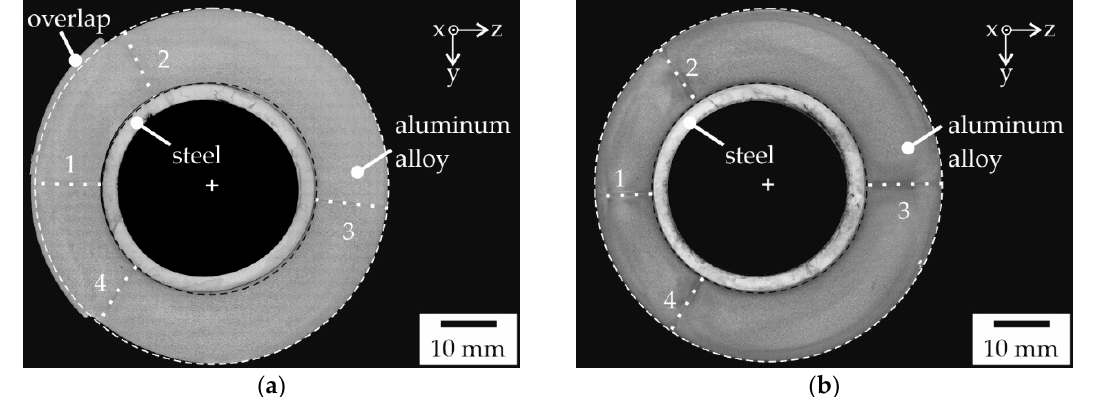
Figure 7. Cross-section of a sample taken from ( a ) the start of the compound profile, i.e., after a macroscopically closed longitudinal weld seam had formed and ( b ) the end of the compound profile, which was produced with an extrusion ratio of 9:1; etching: HF / H 2 SO 4 mixture; the position of the longitudinal weld seams is highlighted by dotted lines; the interpolated outer contour of the steel tube is highlighted with black dashed lines; the (in case of ( a ) interpolated) outer contour of the aluminum is highlighted with white dashed lines.